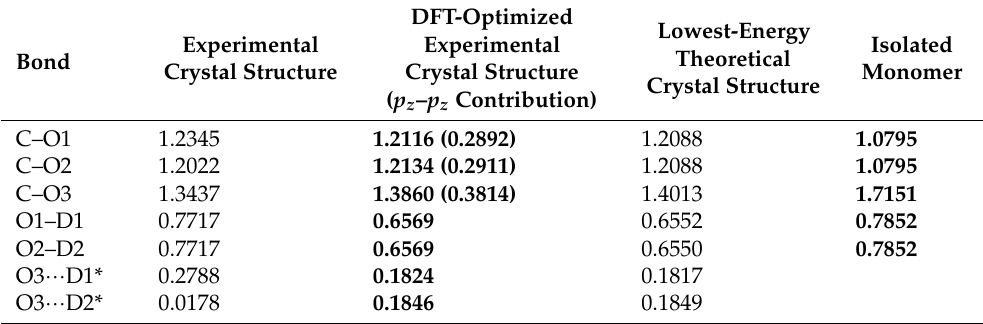
Table A5. Integrated crystal-orbital bond indices (ICOBI) of carbonic acid extracted from plane waves for the experimentally determined crystal structure, the DFT-optimized experimental crystal structure (in bold face, see text), the lowest-energy theoretical crystal structure, and the isolated monomer (in bold face, see text).